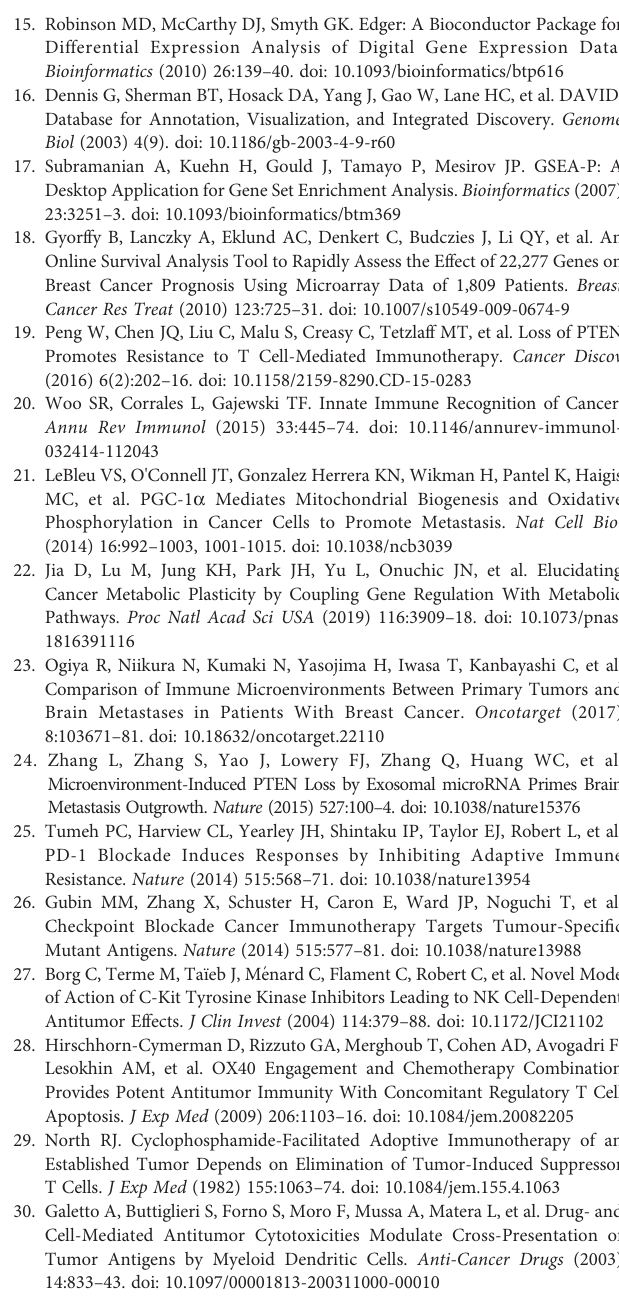
Supplementary Table 6 | The core genes of oxidative phosphorylation pathway enriched in BCBMs compared with BCs. Supplementary Table 7 | The results of DEGs crossed with core genes in oxidative phosphorylation pathway enriched in BCBMs compared with BCs. Supplementary Table 8 | The results of gene set enrichment analysis in BCBMs compared with BCEMs (GSE14017 and GSE14018). The normalized enrichment score (NES) represented the degree of enrichment of the KEGG pathway in BCBMs compared with BCs. P values corresponding to each NES were determined by the Fisher ’ sexacttest(1000permutation)inGSEA.AdjustedPvaluescorrespondingto each NES were determined by Benjamini-Hochberg (BH) correction in